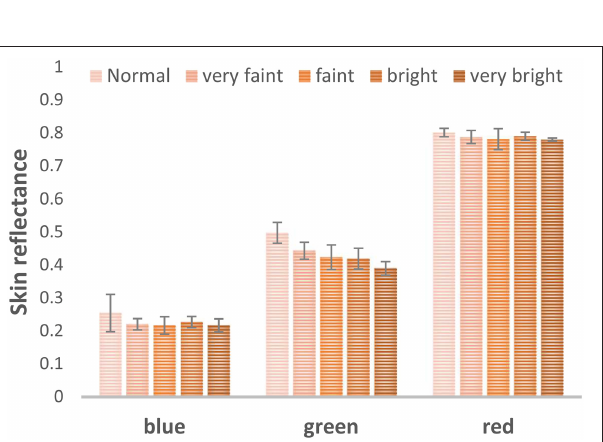
FIGURE 8 | Skin reflectance of normal skin and erythema regions (A) averaged over three subjects; (B) smoothed data from one subject between 500-650nm. Error bar shows standard error.